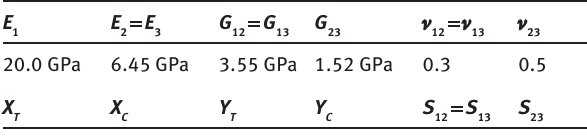
Table 2: Properties of GFRP orthotropic lamina.